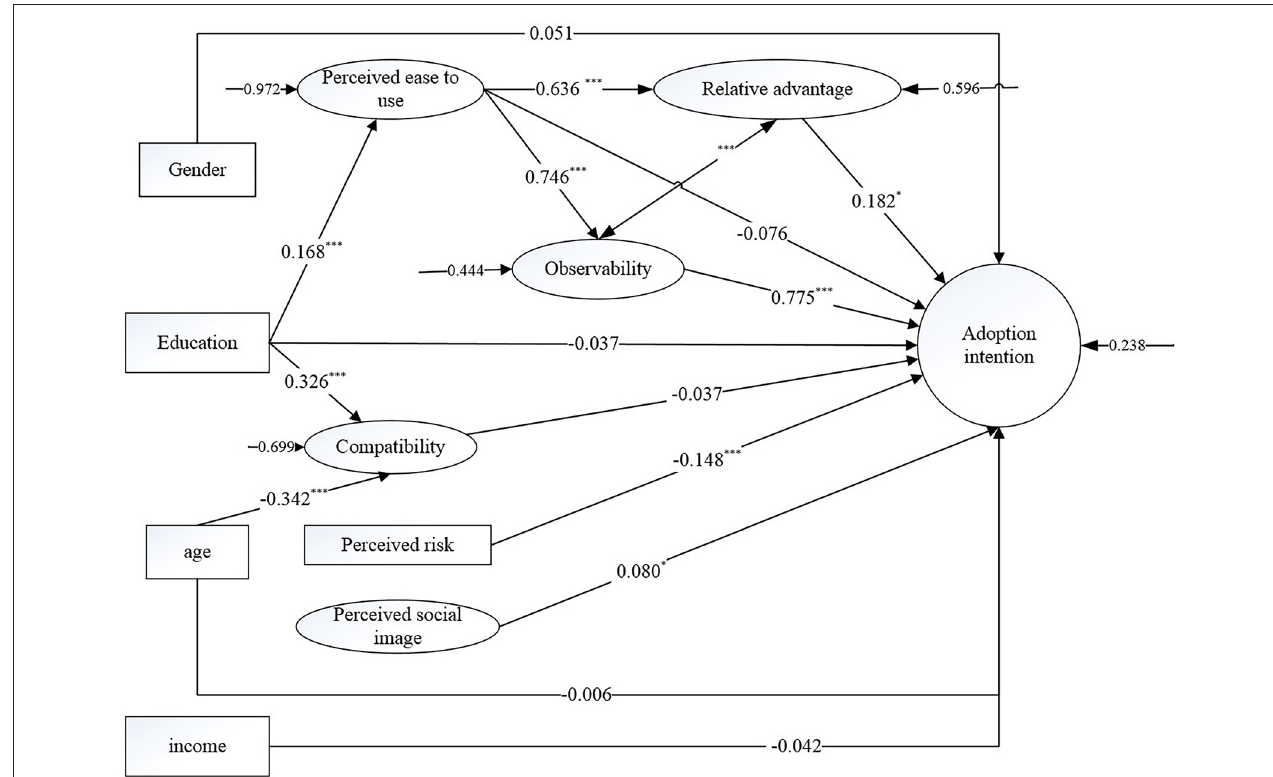
FIGURE 2 | Results of structural equation model for adoption